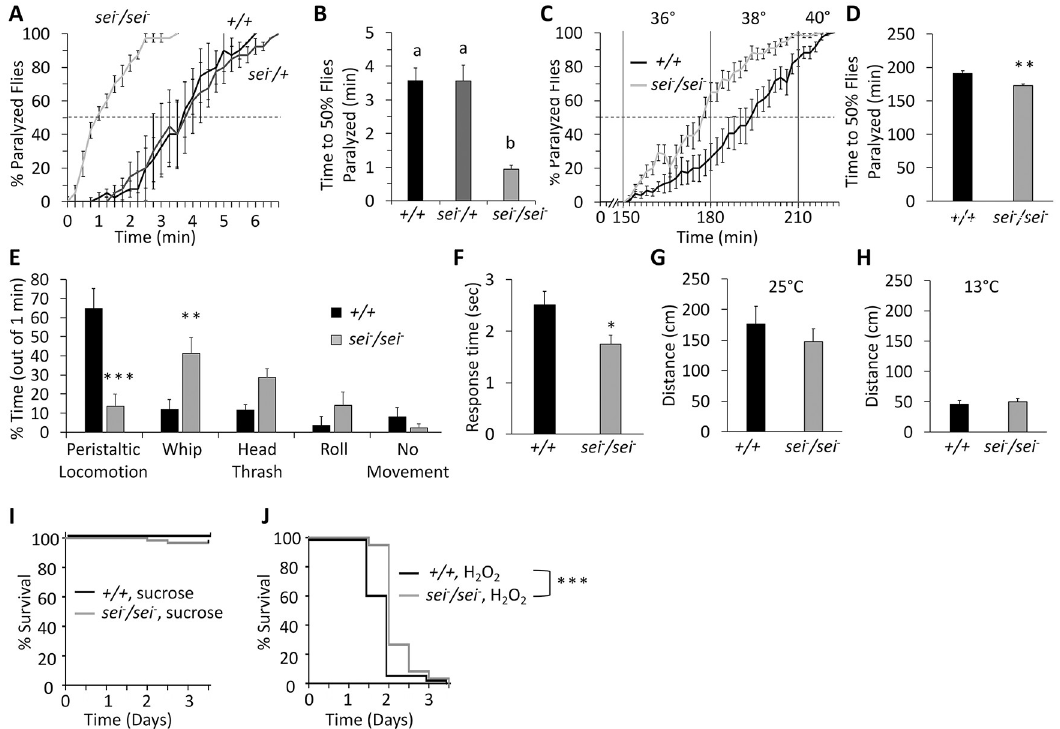
Fig 2. sei mutants display heat hypersensitivity. A-B ) Acute heat assay paralysis behavior of homozygous and heterozygous seiP mutants and controls. n = 4 vials/genotype, 10 flies per vial, placed in 41–42˚C water. Letters above bars represent significantly different groups by ANOVA ( p < 0.001) followed by Tukey’s post hoc analysis ( p < 0.01). C-D ) Gradual heat assay paralysis behavior of seiP mutant flies and controls. n = 12 vials, 10 flies per vial. E ) Larval behavioral responses when placed on an agar surface heated to 37 ˚C, in seiP mutants and controls. n = 9. F ) Response time of seiP mutant larvae and controls to 50˚C thermal nociception assay. G-H ) seiP mutant and wildtype larvae distance travelled in five minute trials at room temperature (25˚; n = 6) or cold temperature (13˚; n = 12). I-J ) Survival of adult male seiP mutants and controls exposed to sucrose alone or with H 2 O 2 (n = 60 per group). Significance determined via log-rank (Mantel-Cox) test. Data are presented as mean ± SEM, � p < 0.05, �� p < 0.01, ��� p < 0.001 (Student’s t -test unless otherwise